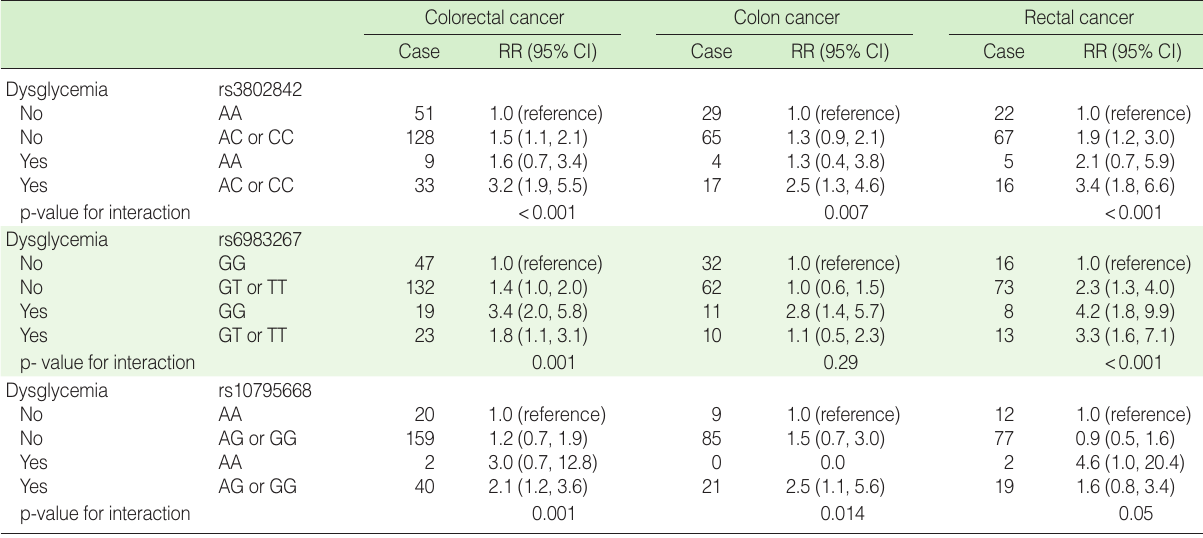
Table 3. Age- and gender-adjusted combined effect of SNP rs3802842 and dysglycemia on the risk of colorectal cancer among subjects with SNP data